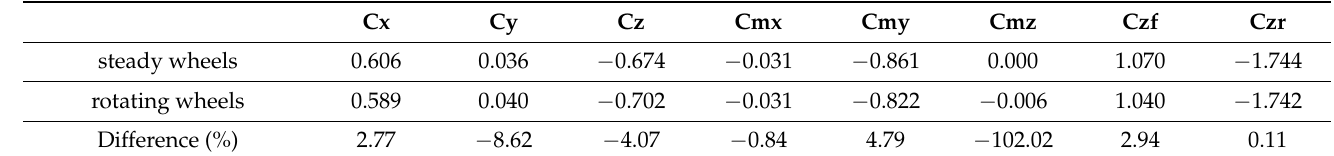
Table 4. Parameters of the car model with blocked wheels and rotating wheels.